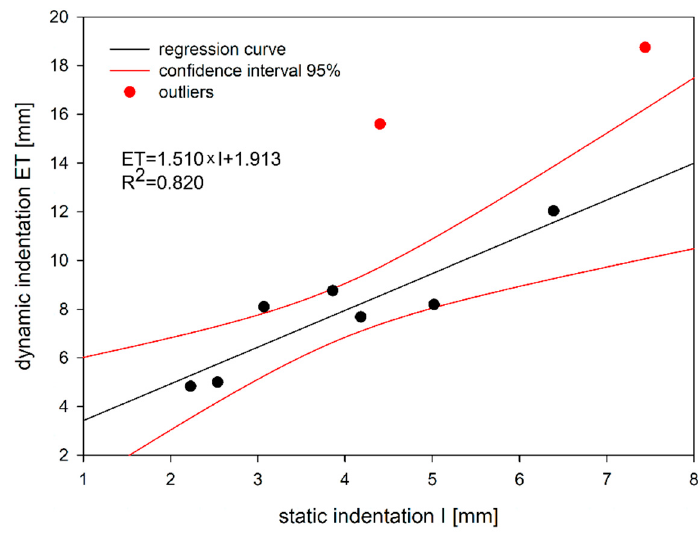
Figure 16. Relationship between static and dynamic indentation.